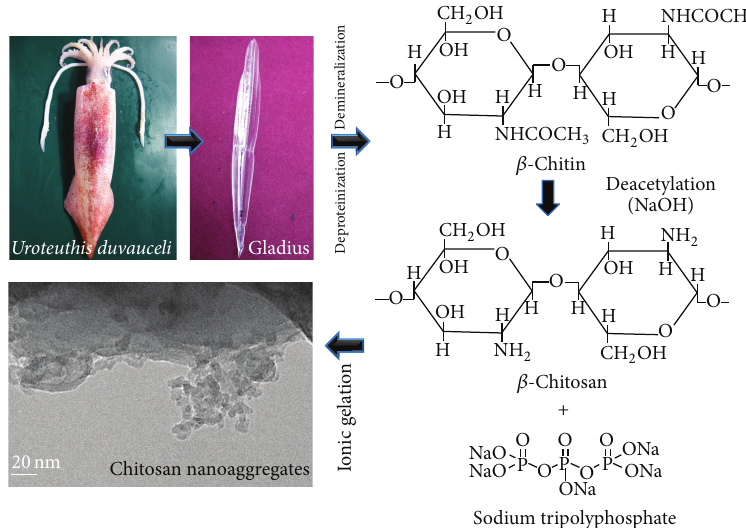
Scheme 1: Illustrating the steps involved in the synthesis of chitosan nanoaggregates from gladius of squid, Uroteuthis duvauceli .